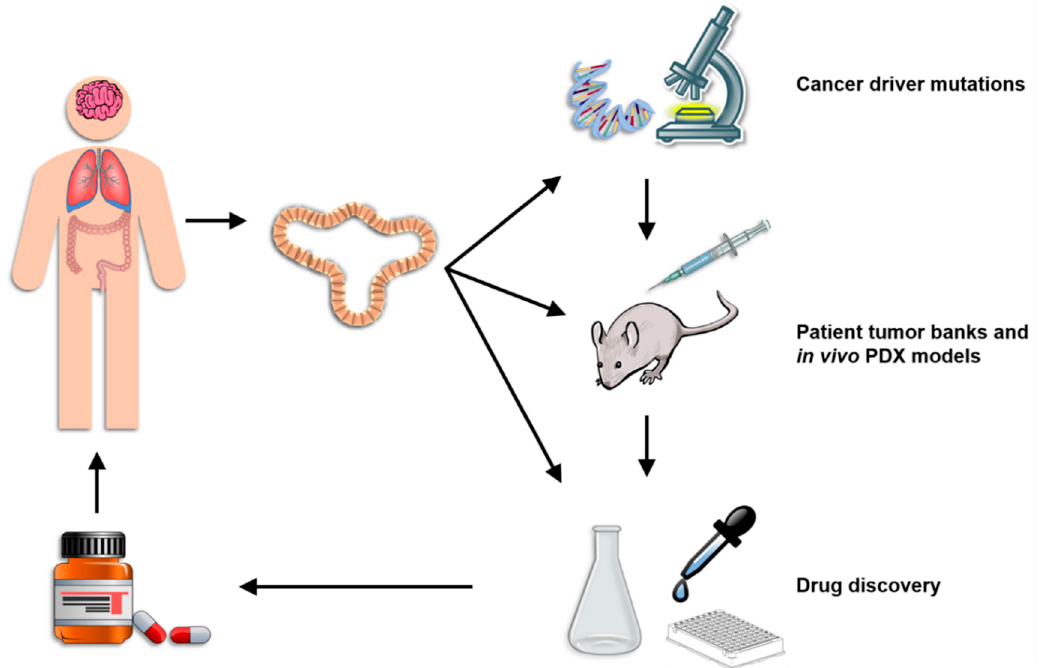
Figure 2. Summary of current applications of organoid technology. Patient-derived organoids can be studied molecularly to elucidate the function of driver mutations, injected into recipient mice to study in vivo growth patterns and drug sensitivity, and used in the development of novel drug compounds. The versatility of the organoid system renders them an important tool in the implementation and advancement of precision medicine.